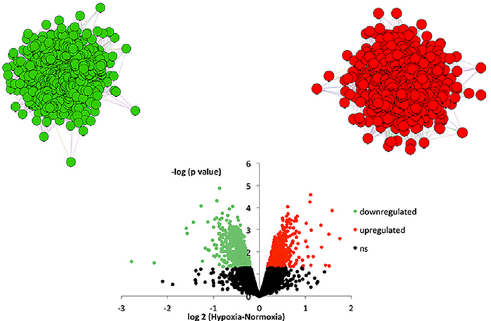
Fig 1. Volcano plot illustrating increases and decreases in pituitary gene expression in hypoxic versus normoxic fetuses. Differences between groups are represented on the x-axis as differences in expressed in values of logarithm of 2. Probability values are represented on the y-axis as values of logarithm of 10. Points drawn above the dashed line are statistically significant ( P < 0.05). Statistically significant increases in gene expression are shown in red and statistically significant decreases in gene expression are shown in green. Above the volcano plot are inferred networks of the upregulated (red) and downregulated (green) genes, plotted as force-directed layouts of the networks.